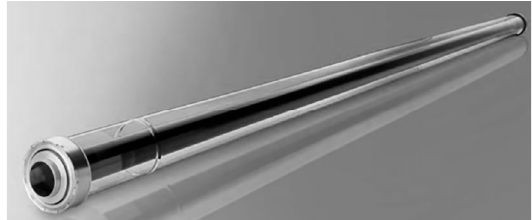
Figure 1. Absorber tube receiver Various materials and processes have been studied for obtaining antireflective surfaces, and silicon oxide (SiO obtained by the sol-gel process is the one that provides the best results of reflectance 1-5 . In the sol-gel process is a transition occurs from a sol system to a gel system through the establishment of connections between colloidal particles or polymeric chains with the formation of a three-dimensional solid network 8 . Usually, the synthesis of silica particles,